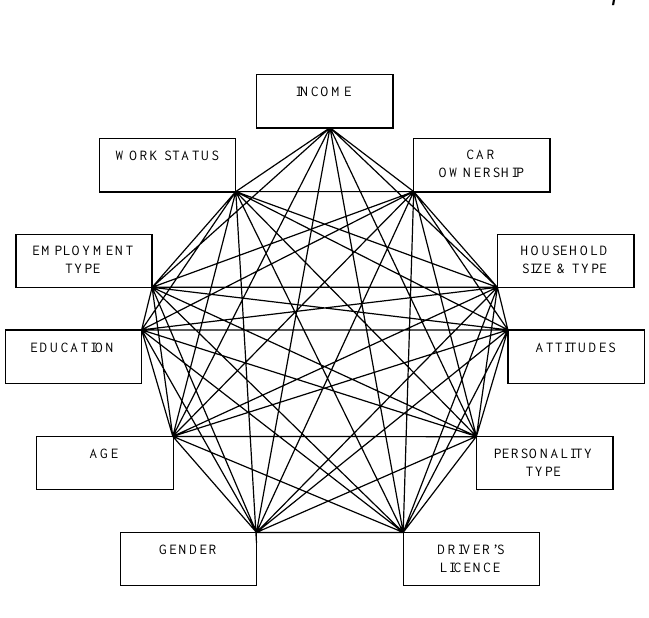
Figure 3. Interactions between socio-economic factors "...in Britain, there is a strong relationship between the population density of residential areas and the average income levels of the residents. Lower income levels in high density areas will have implications for both lifestyles and levels of car ownership. This... warns against making simple conclusions about the independent nature of density and, in particular, on the extent to which a policy favouring higher density in new suburban developments will have beneficial effects on travel behaviour. In principle, the effects of density, location and income levels could be separated by a statistical analysis which controls for the latter two variables. However, the necessary data for this analysis are not available. Some of the data which are available suggests that socio-economic factors - and in particular car ownership - are more significant than density per se in explaining inter-personal and inter-area variations in travel